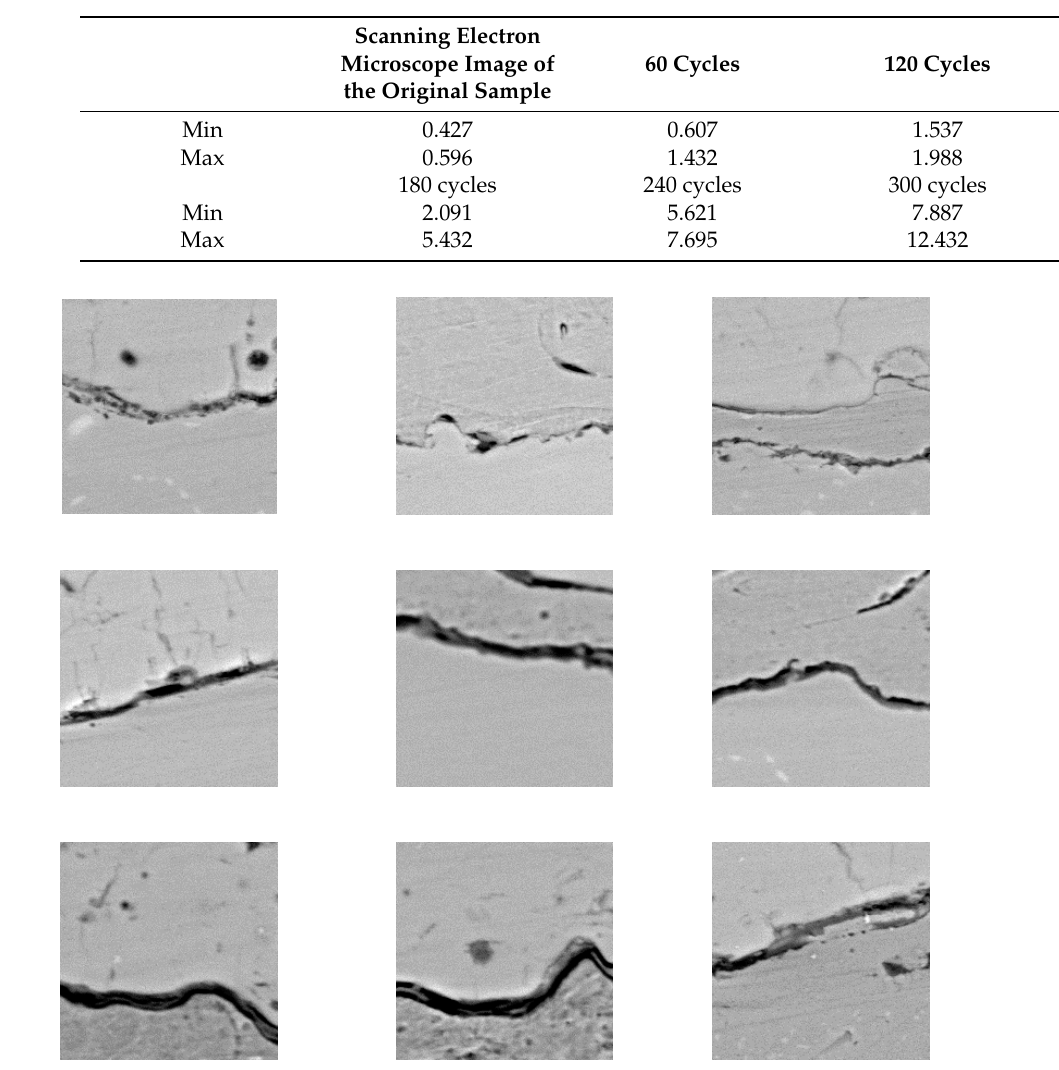
Table 5. Statistical table of test thickness of some samples of SEM with different times of thermal vibration (unit: µ m).